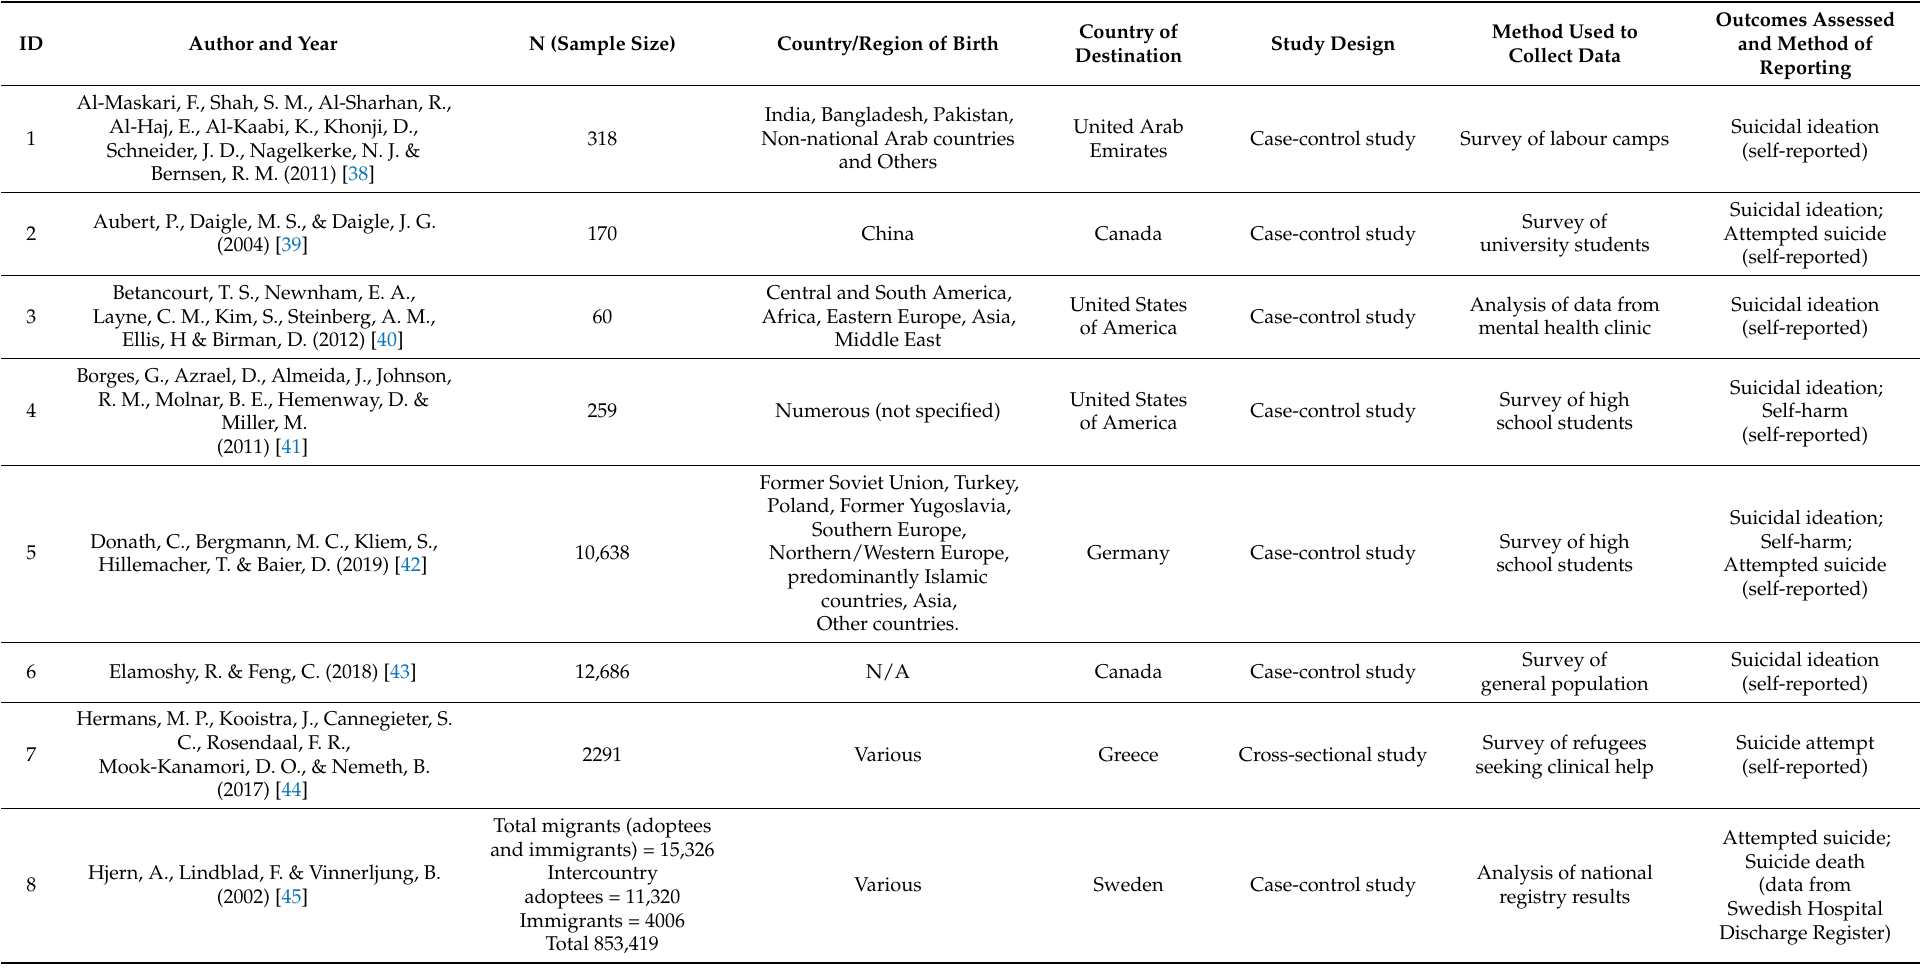
Table 1. Characteristics of Included